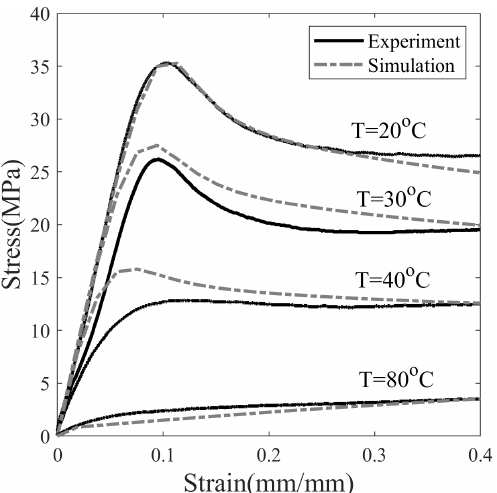
Figure 8. Stress response of uniaxial tension at a strain rate of 0.0013 s − 1 of SMP at different